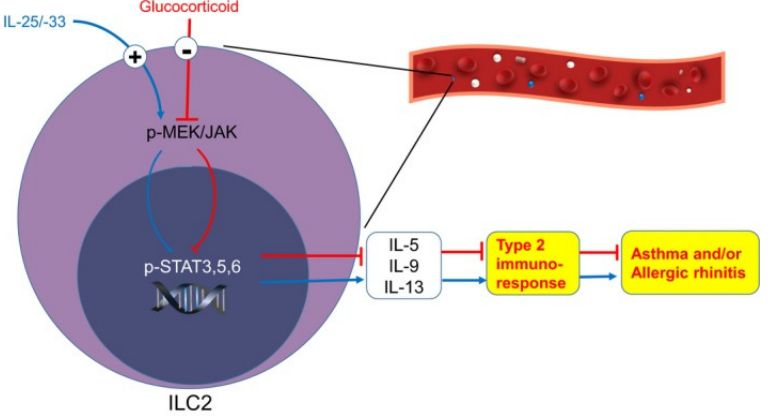
Figure 2. High levels of IL-5 and IL-13 produced by ILC2s via STAT3, STAT5, and STAT6 signaling pathways. Image of inflammatory signaling pathway associated with ILC2 activation adapted from Yu et al. [74].